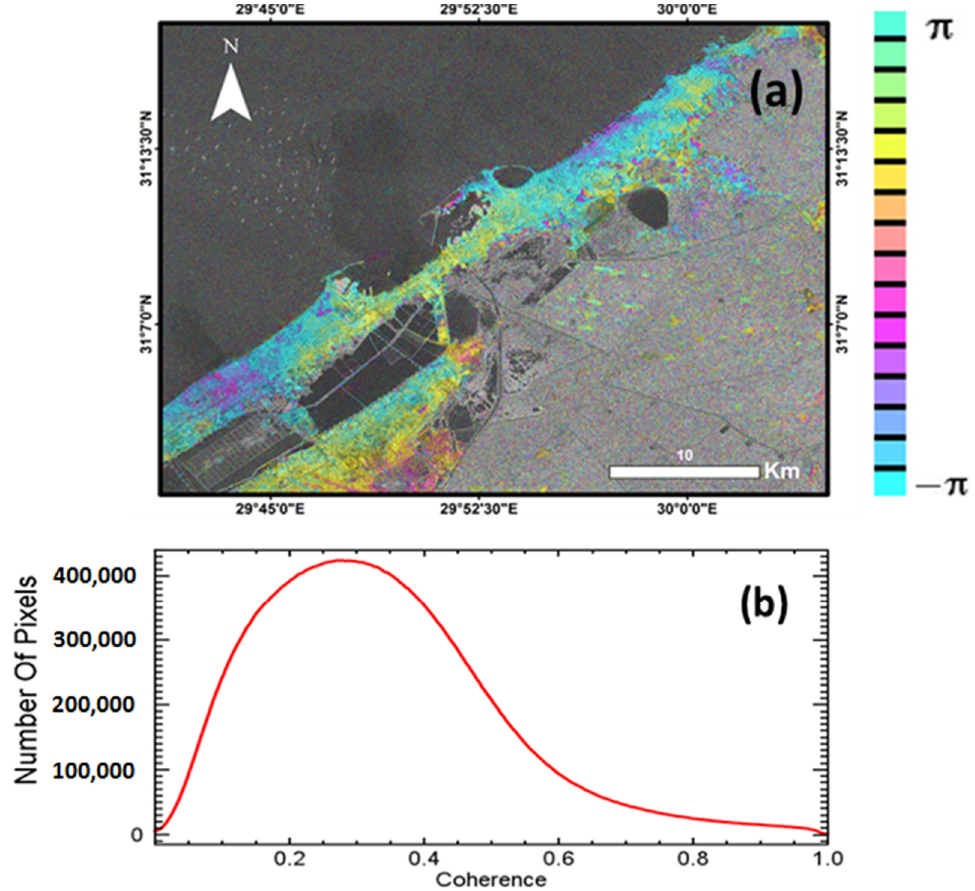
Figure 7. Wrapped Sentinel-1 interferogram with low coherence. The cause is the very large temporal and normal baseline between the two acquisitions used to make the interferogram ( a ). The histogram illustrates the coherence value between two interferogram pairs (master 15 December 2018 and Slave 10 June 2019) ( b ).